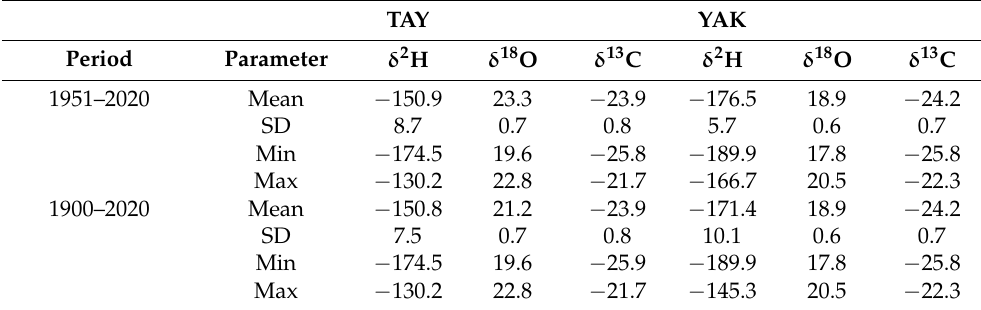
Table 1. Mean, standard deviation (SD), minimum (min) and maximum (max) values calculated for newly developed tree-ring δ 2 H, δ 18 O and δ 13 C chronologies from merged and averaged YAK and TAY datasets for the periods from 1951 to 2020 and from 1900 to 2020. TAY YAK